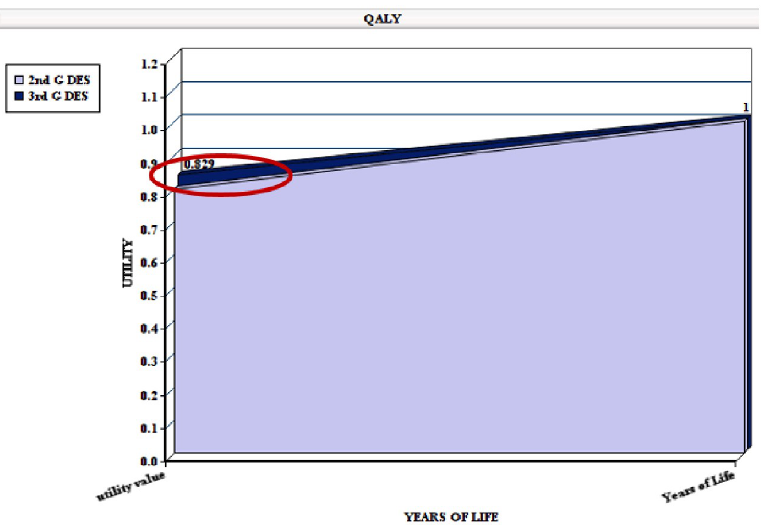
Fig 2. QALY gained by 3rd G DES (QALYs gained is marked by red